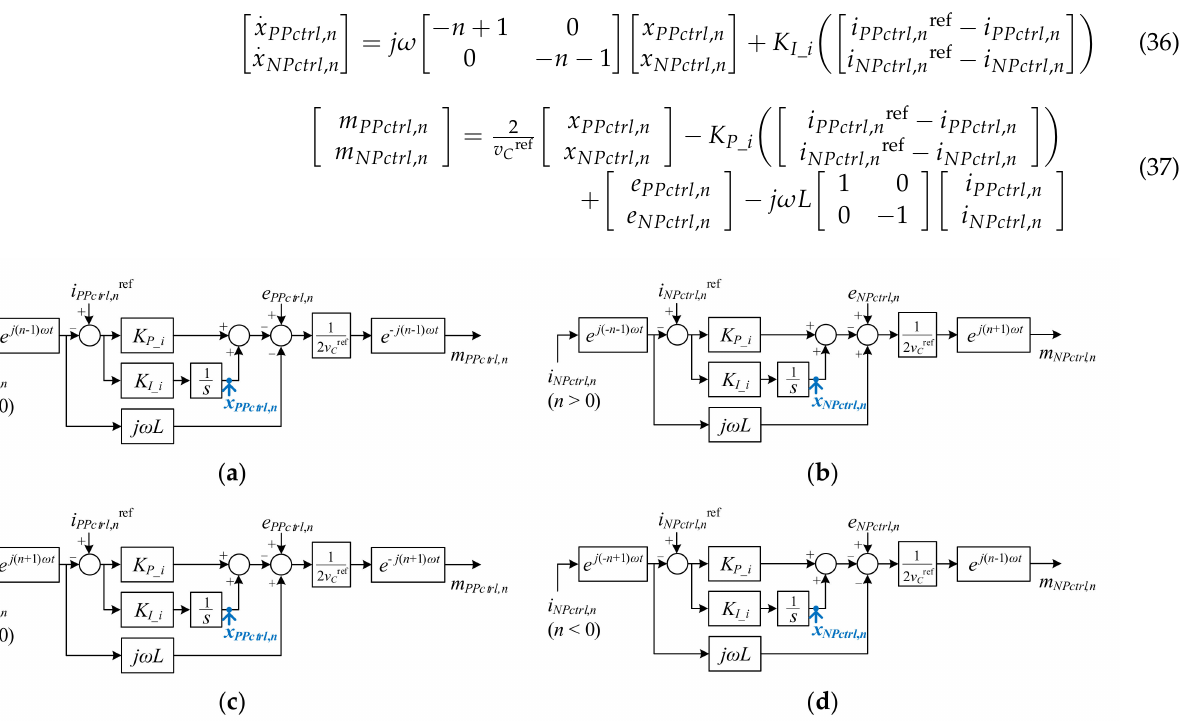
Figure 4. Diagram of the n th-Order Positive-Sequence Current Loop. ( a ) n > 0, positive-sequence component, ( b ) n > 0, negative-sequence component, ( c ) n < 0, positive-sequence component, ( d ) n < 0, negative-sequence